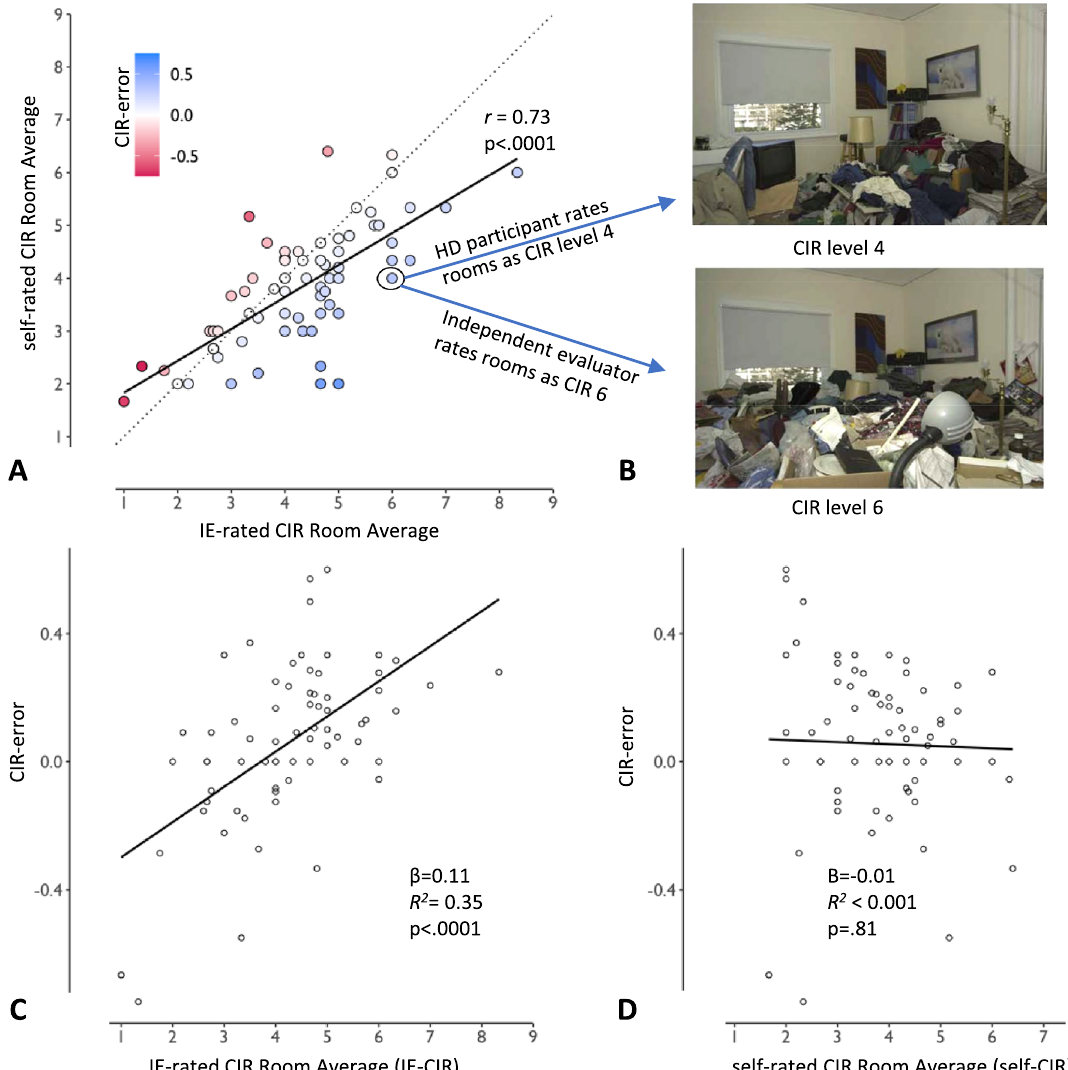
Figure 2. Underreporting of clutter, a proxy for anosognosia, is common in hoarding disorder and increases with severity of clutter. ( A ) Independent evaluator (IE) and self-rated Clutter Image Rating (CIR) scores are correlated (solid black line), but most individuals with hoarding disorder underrate clutter relative to IE ratings (e.g., all points below the x = y dotted line). CIR-error (shading, calculated as (IE-CIR – self-CIR)/IE-CIR) represents the degree of underreporting (blue) or overreporting (red) relative to IE-CIR score. ( B ) Example living room images from the CIR scale (adapted with permission from Steketee and Frost 79 ). The circled data point in panel A represents one individual with HD who self-rated their rooms on average as level ‘4’ (upper panel), whereas an IE rated the same rooms on average as level ‘6’ (lower panel). ( C ) Clutter underreporting (CIR-error) increases with objective clutter score (IE-CIR). ( D ) Clutter underreporting is not predicted by self- reported clutter